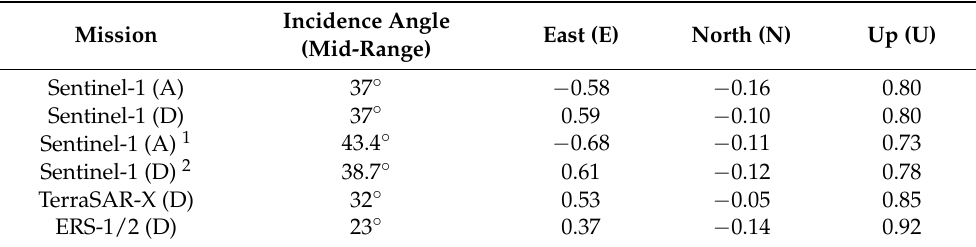
Table A1. Comparison of decomposition sensitivity (unit vector) for the InSAR LOS estimate from former and current SAR missions (cf. Equation (2) or (3)). All values are estimated at mid-swath incidence